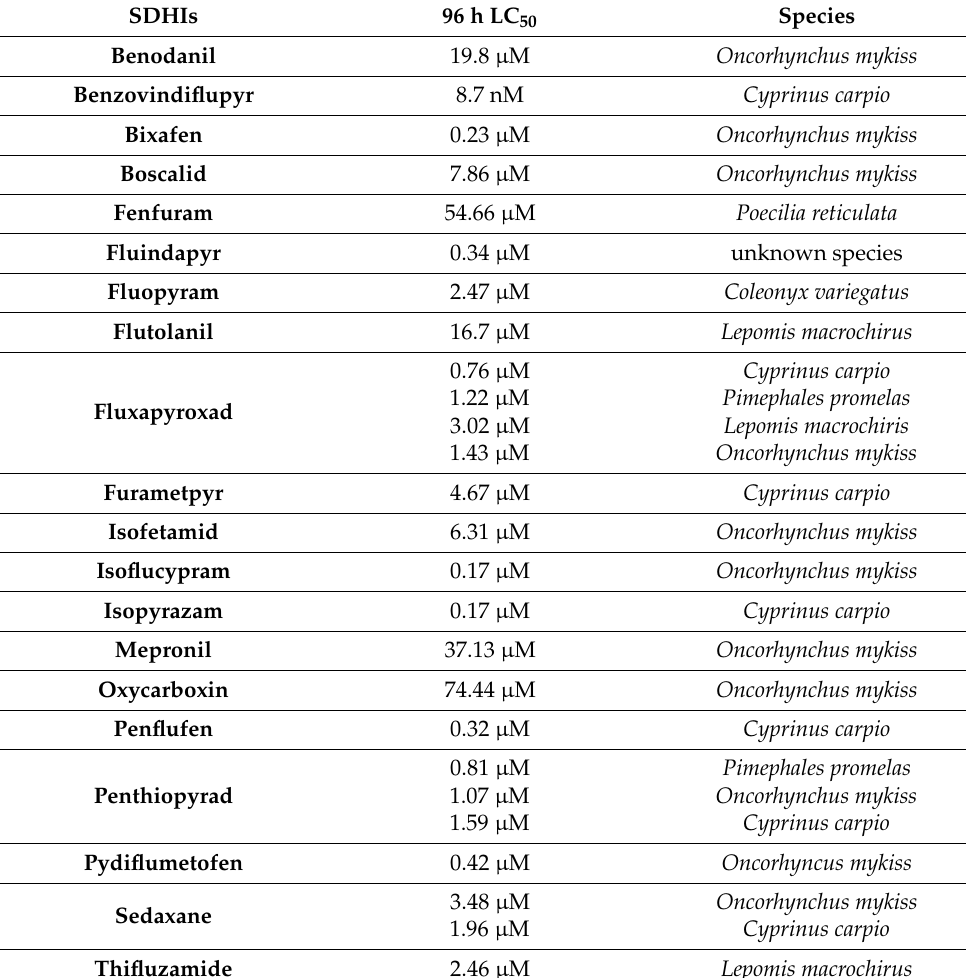
Table 2. LC 50 values of SDHIs determined in fish species other than